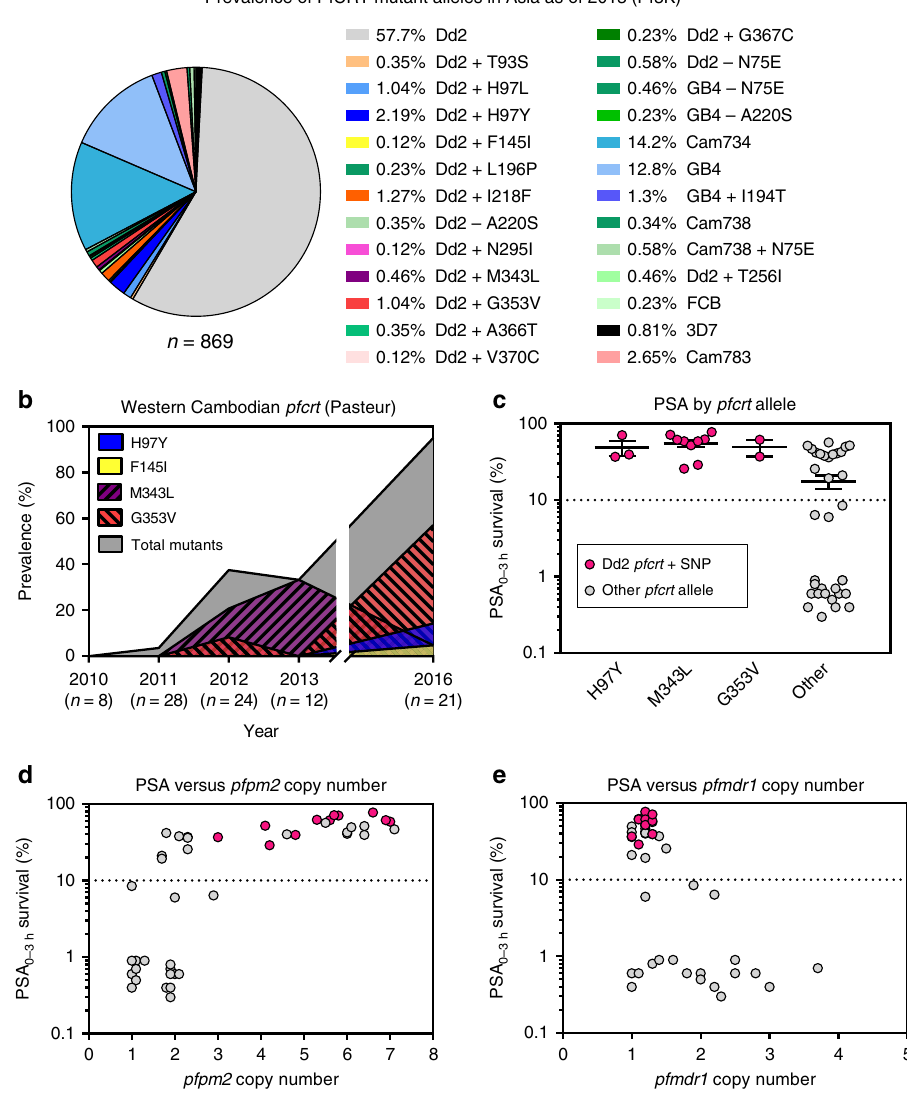
Fig. 1 Emergence of novel PfCRT mutations in SE Asia that associate with elevated PSA 0 – 3h survival. a Sequence analysis of 869 P . falciparum genomes from multiple Asian countries, generated by the MalariaGEN consortium Pf3K database 37 , identi fi ed three major PfCRT haplotypes (Dd2, Cam734, GB4) and the emergence of multiple variants at low prevalence. Haplotypes and their distribution by country are listed in Supplementary Tables 1, 2. Most isolates were collected in 2011 – 12, with additional Cambodian samples from 2009 to 2010 and 2013 (Supplementary Fig. 2). b Genome analysis of a separate set of 93 western Cambodian isolates, collected over the period 2010 – 16 by the Pasteur Institute in Phnom Penh, Cambodia (Supplementary Table 3), provided evidence of a rapid increase in the prevalence of novel PfCRT variants on the Dd2 allelic background. A subset of 51 of these Pasteur Cambodian isolates from the period 2010 – 13 were also typed for PSA 0 – 3h survival rates and pfpm2 and pfmdr1 copy numbers, as shown in c – e . c Isolates harboring mutations H97Y, M343L, or G353V were associated with elevated PSA 0 – 3h survival rates, an indicator of PPQ resistance (F145I had not been detected at that time). PPQ-resistant isolates were also observed that lacked these speci fi c mutations. The dashed line of 10% survival represents a previously designated resistance threshold associated with a 32-fold increased risk of clinical failure 11 . d All PPQ-resistant parasites in this sample set had multiple copies of pfpm2 , although some parasites with multiple copies were also in the PPQ-sensitive survival range. All parasites harboring one of the three PfCRT mutations in c and d (designated in magenta) were multicopy pfpm2 . e All PPQ-resistant parasites observed were single-copy pfmdr1 . Magenta samples harbored novel PfCRT mutations represented in